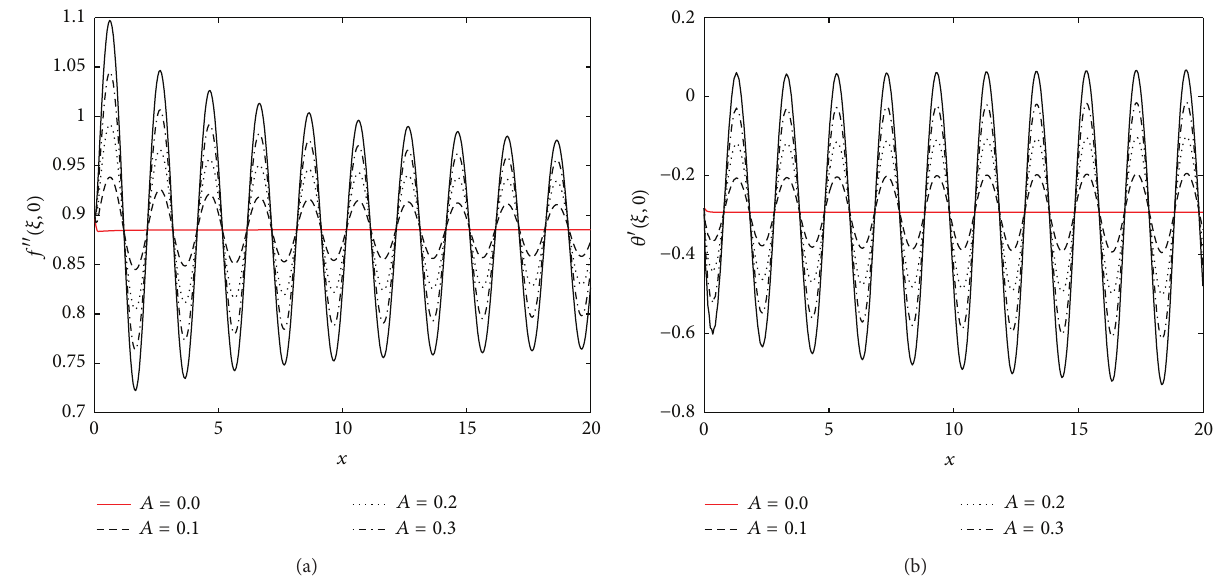
Figure 7: Effect of the 𝐴 on 𝑓 󸀠󸀠 (𝑥,0) and 𝜃 󸀠 (𝑥,0) for Le = 10 , Pr = 1 , 𝜎 = 0.02 , Nr = 0.1 , Nt = 0.3 , and Nb = 0.5 .